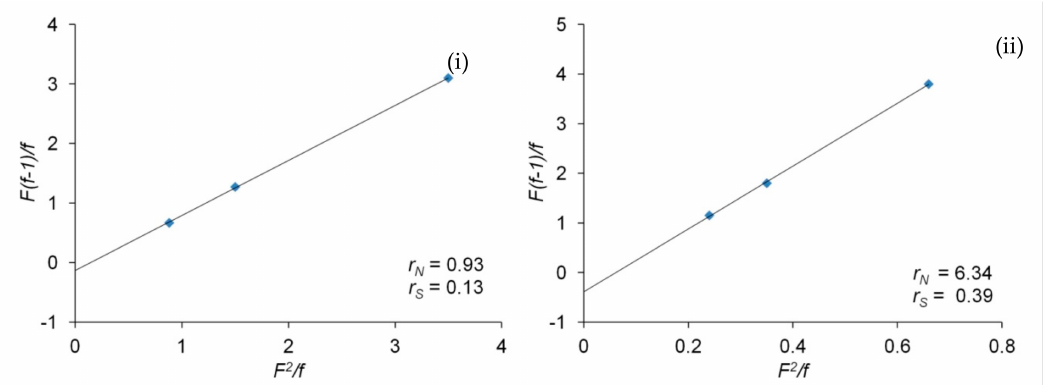
Figure 4. Fineman–Ross plots for copolymerization of N / S by 1b with ( i ) MMAO and ( ii ) B(C 6 F 5 ) 3